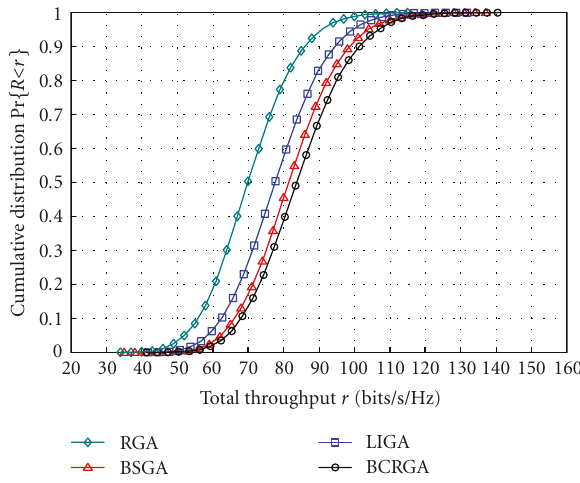
Figure 8: Cumulative distribution of total throughput per cell with code constraints on the number of users per assignment group ( K = 64 users/cell and WFPA in use).